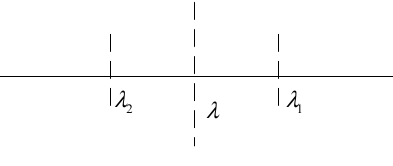
Figure 2. The local decision thresholds.